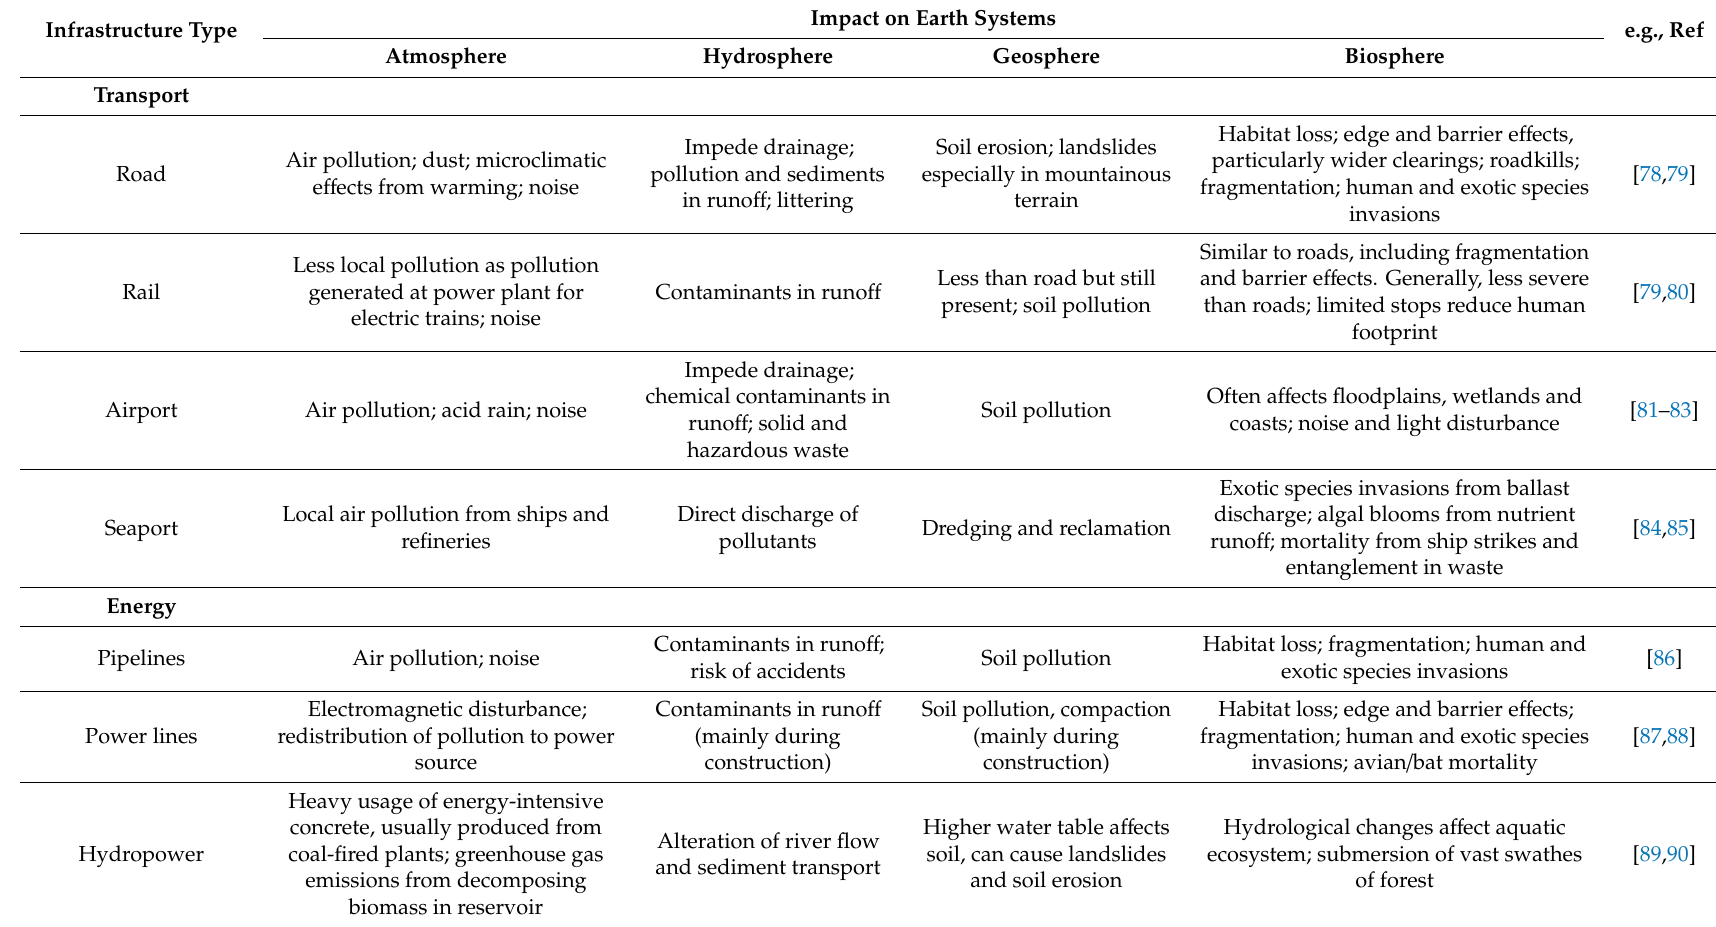
Table 2. A summarised review of key direct impacts associated with a range of infrastructure